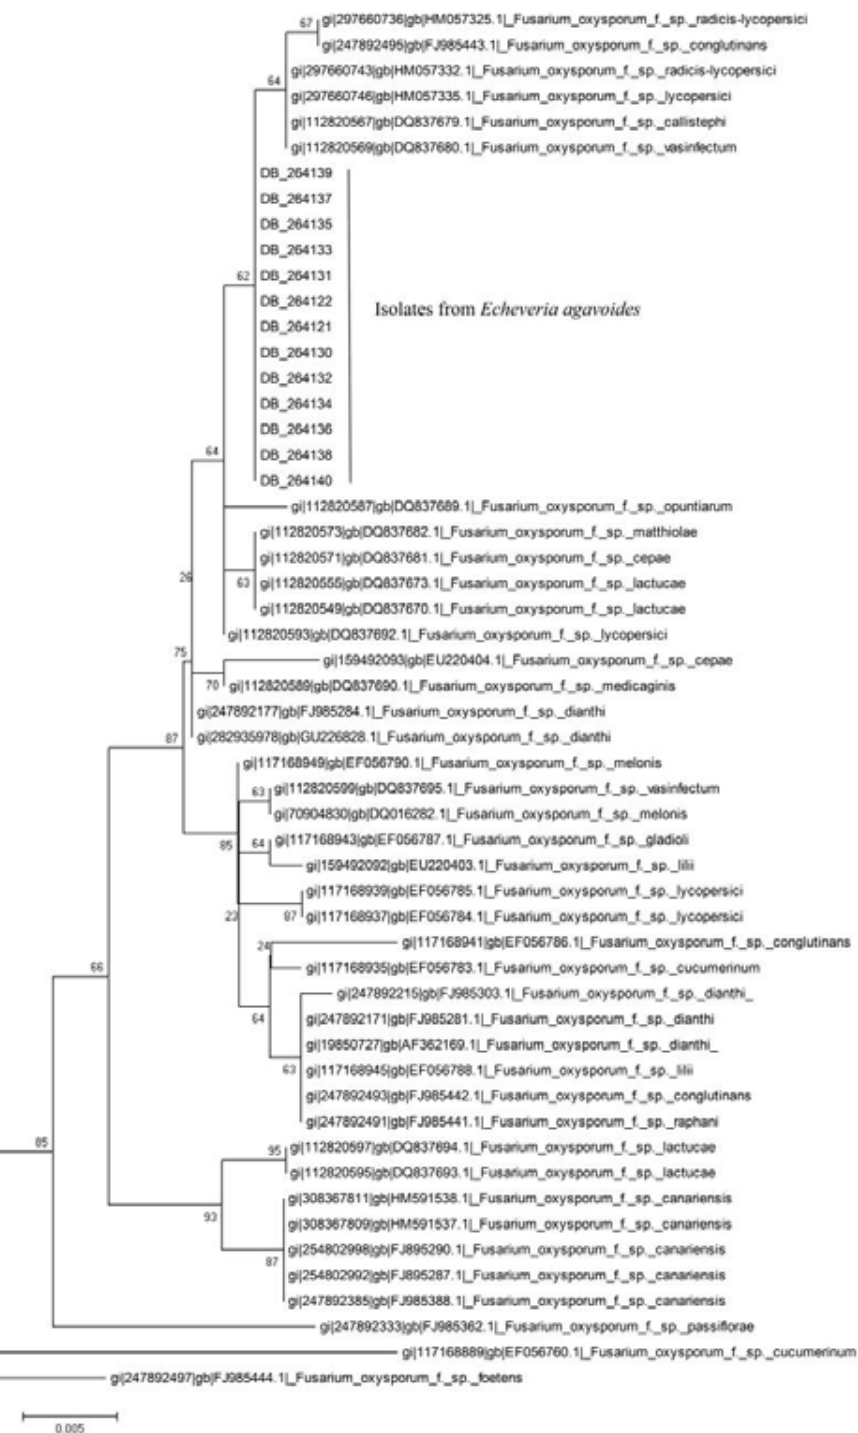
Figure 1. Phylogenetic tree based on EF-1α gene sequences, built by Mega5 software with the Neighbor joining method with 1,000 bootstrapping